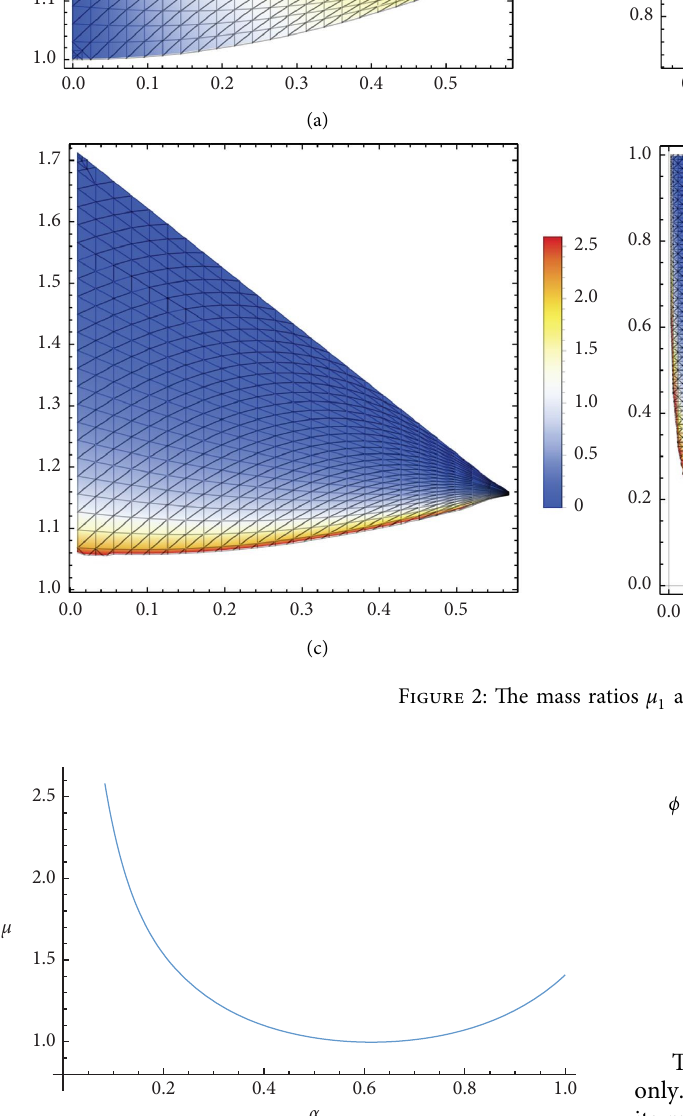
Figure 3: Te mass ratios μ in case